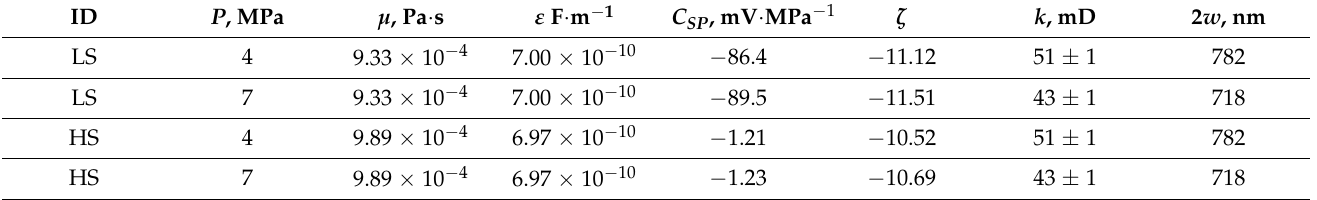
Table 3. Rock, fluid and electrokinetic properties of NaCl experiments at 7.35 × 10 − 3 M (LS) and 0.7 M (HS) ionic strengths. The confining pressure is denoted by P in the table and k is the measured absolute permeability. The fracture aperture (2 w ) is interpreted using Equation